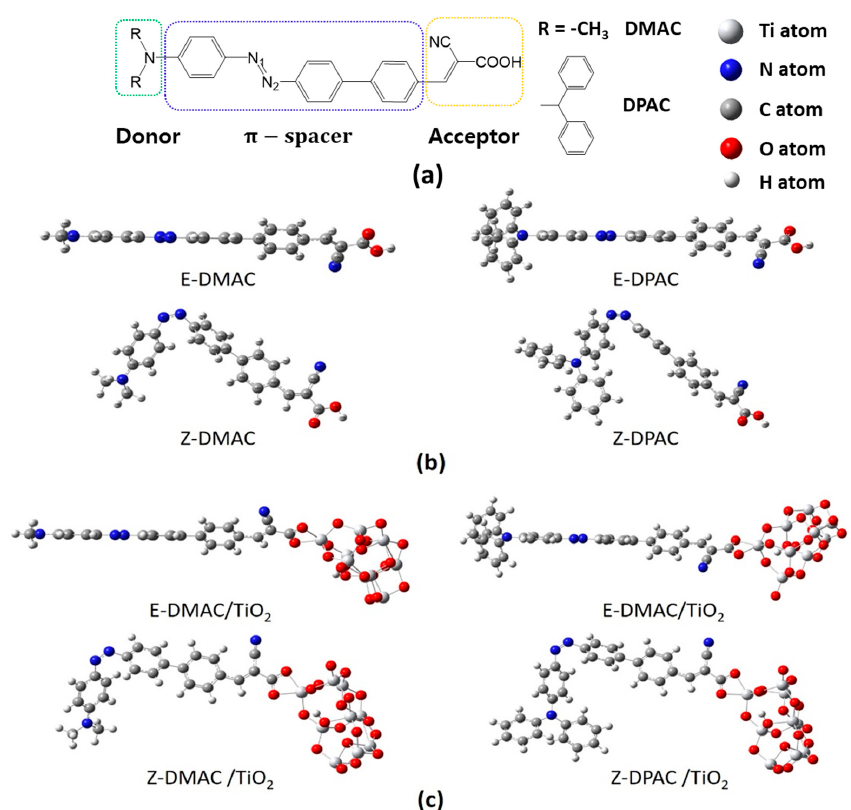
Figure 1. ( a ) Molecular structure of the dyes, and optimized geometries for trans (E) and cis (Z) structures of 2-cyano-3-(4 ′ -(4-(dimethylamino)phenyl)diazenyl)-[1,1 ′ -biphenyl]-4-yl)acrylic acid (DMAC) and 2-cyano-3-(4 ′ -(4-(diphenylamino)phenyl)diazenyl)-[1,1 ′ -biphenyl]-4-yl)acrylic acid (DPAC) as ( b ) isolated dyes and ( c ) dye / TiO 2 complexes. The titanium, nitrogen, carbon, oxygen, and hydrogen atoms are shown in the legend.